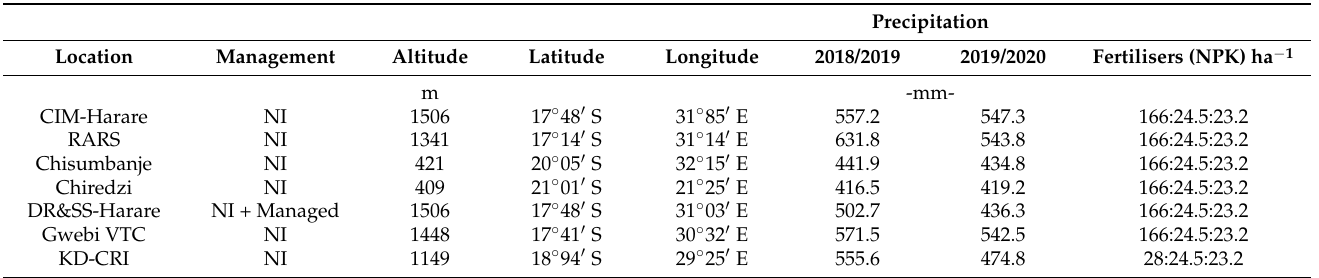
Table 2. Description of experimental sites used in the evaluation of commercial cultivars, experimental hybrids and inbred